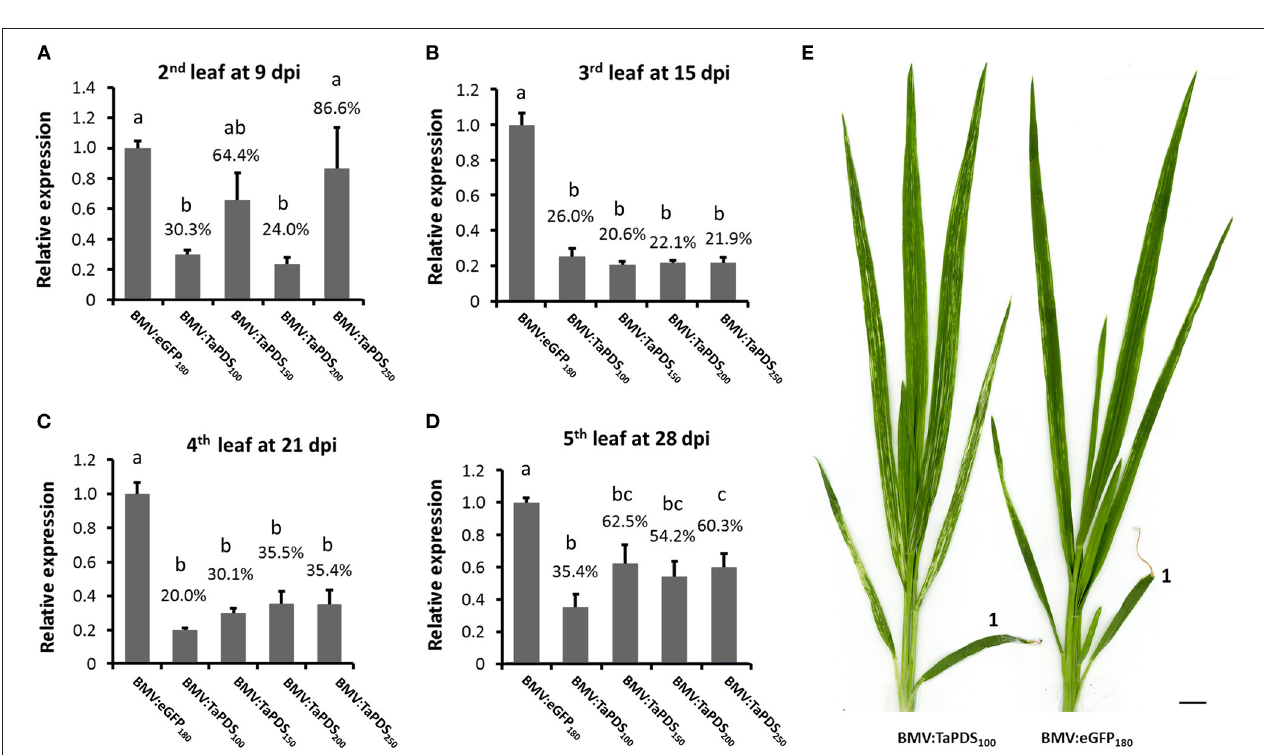
FIGURE 2 | Values in panels (D–F) represent means + SE of four or five biological replicates. Significant differences between treatment mean values in panels (D,E) are indicated by different letters above bars for each treatment ( P < 0.05, significant ANOVA followed by LSD analysis); treatment values in panel (F) were compared